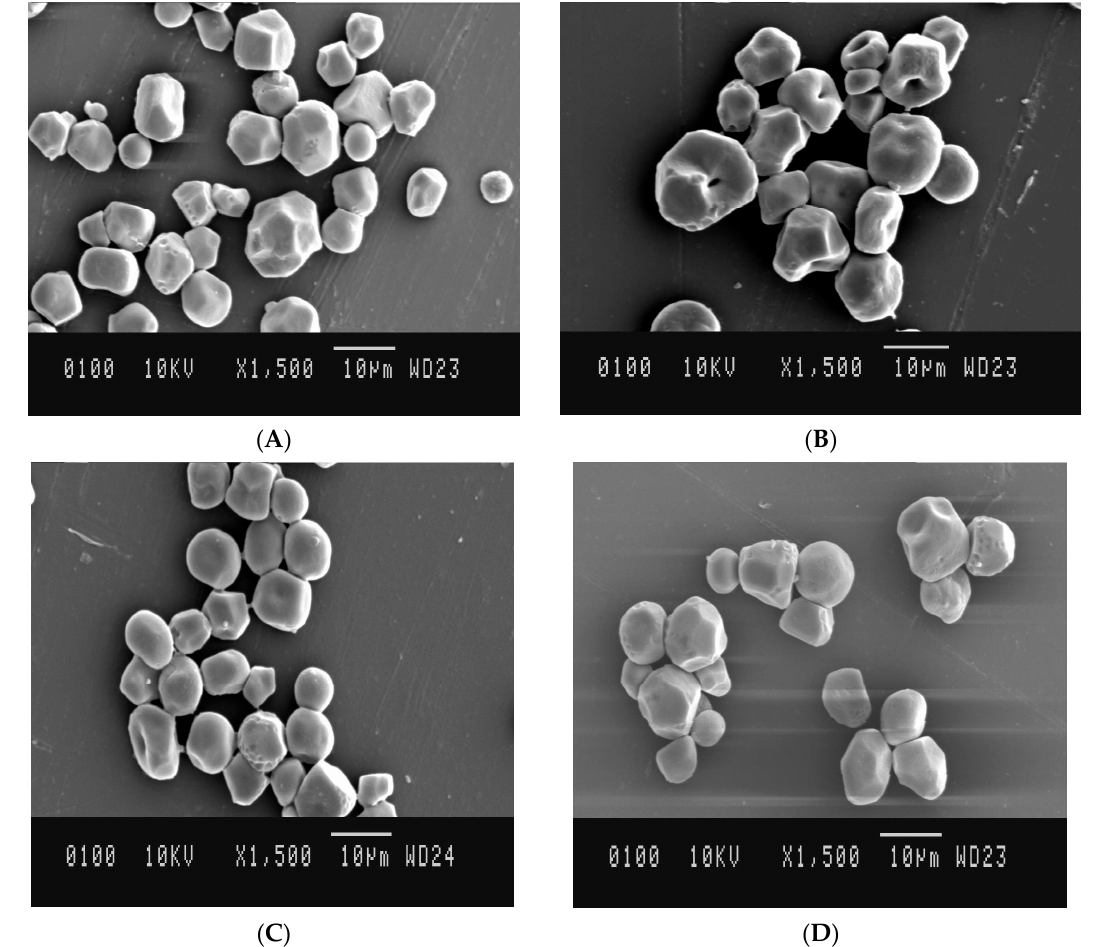
Figure 5. Morphological properties of native and modified starches. ( A ) Native starch ( B ) HMT ( C ) Microwave ( D ) Sonication.